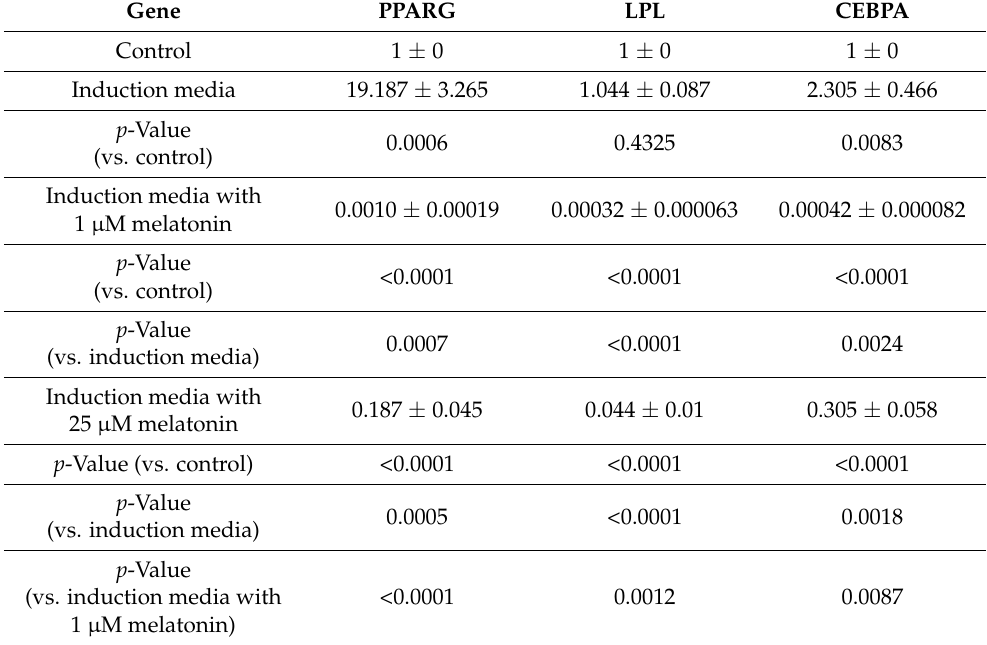
Table 5. Relative gene expression of adipogenesis-related